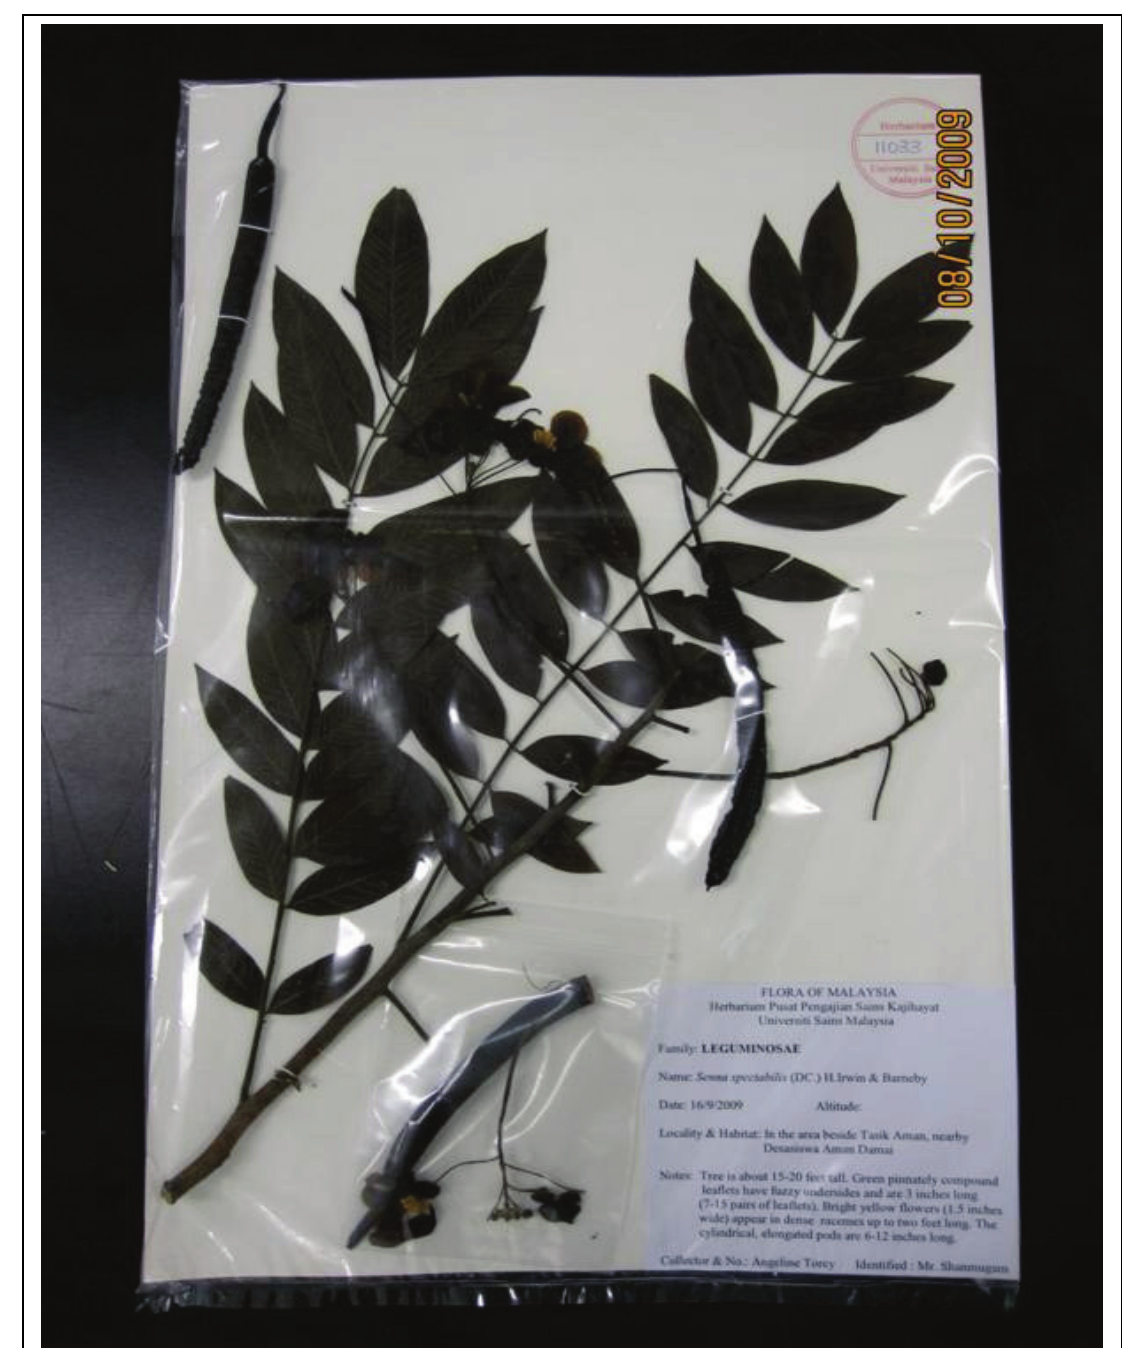
Figure 1. The Cassia spectabilis herbarium